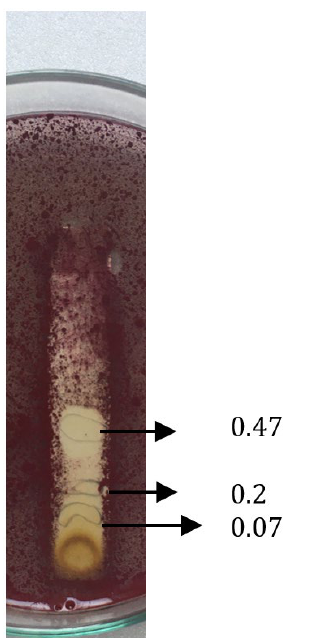
Fig. 9. Agar overlay bioautography of acetone extract of T.catappa leaf showing inhibition of S.aureus (MTCC 7443) at Rf values 0.47, 0.2 and 0.07.